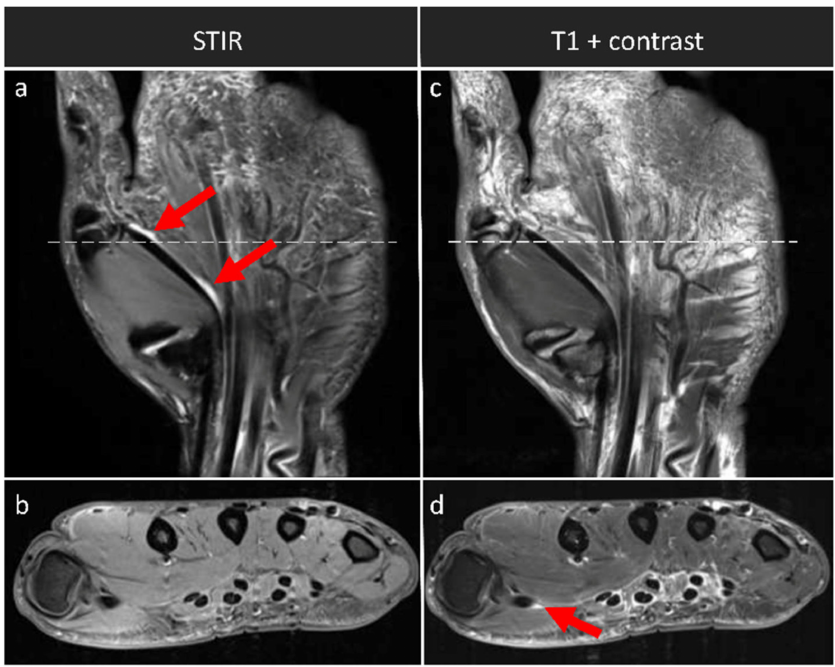
Figure 3. Tenosynovitis in an exemplary patient across the sequences. Coronal STIR ( a ) and axial T1- weighted sequence with fat suppression, yet without contrast agent application ( b ) and corresponding coronal ( c ) and axial ( d ) T1-weighted post-contrast sequences. Axial images were acquired at the level of distal metacarpal bones (as indicated by the white horizontal lines). Tenosynovitis of the flexor tendon of the first digit can be identified in the STIR sequence (dual red arrows in ( a ) and in the contrast-enhanced sequences (single red arrow in ( d )). Right hand of a 48-year-old male